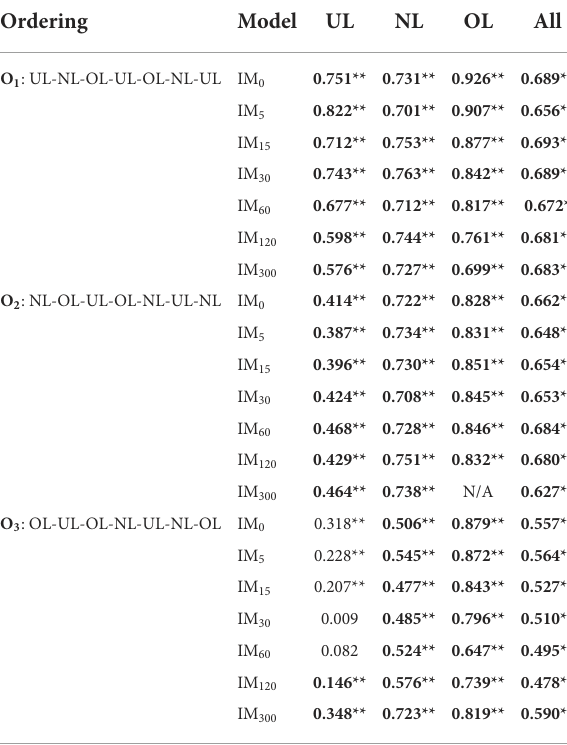
*Indicates p ≤ 0.05 and **indicates p ≤ 0.01. The bold correlations are higher than the